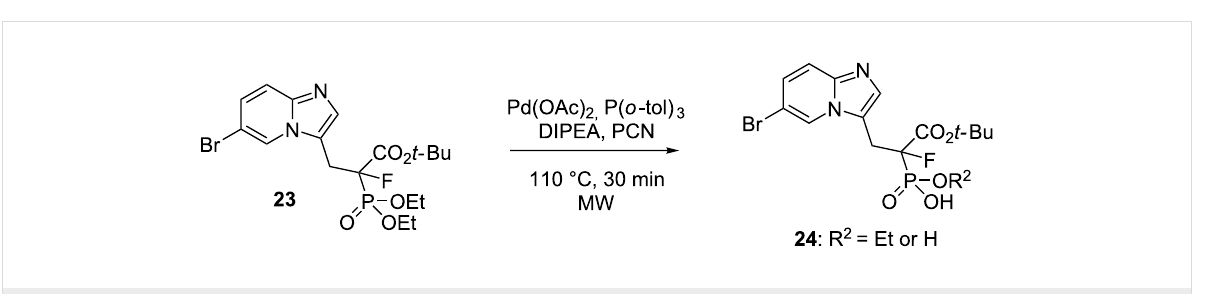
Scheme 2: Dealkylation of fluorinated analog 23 under the Mizoroki–Heck reaction